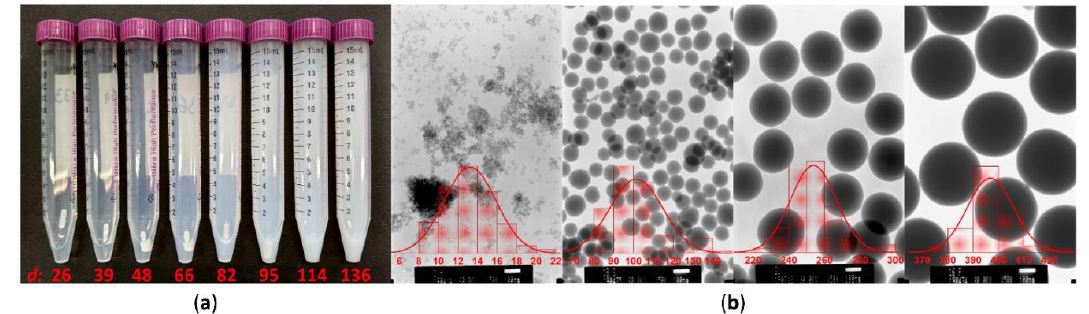
Figure 2. Comparison of different silica nanoparticles prepared using the simplified methodology. ( a ) Turbidity of post-reaction mixtures containing an identical volume fraction of particles with an increasing mean diameter d . ( b ) Transmission electron microscope (TEM) imagesof silica spheres of various sizes, acquired using the same magnification to highlight their differences; average diameter distribution histograms are shown in red. All values are given in nanometers.